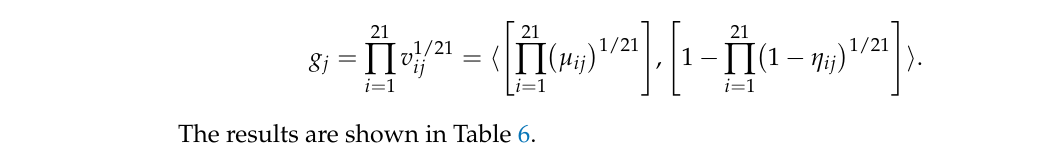
Table 6. Calculations and the obtained matrix of border approximation area G